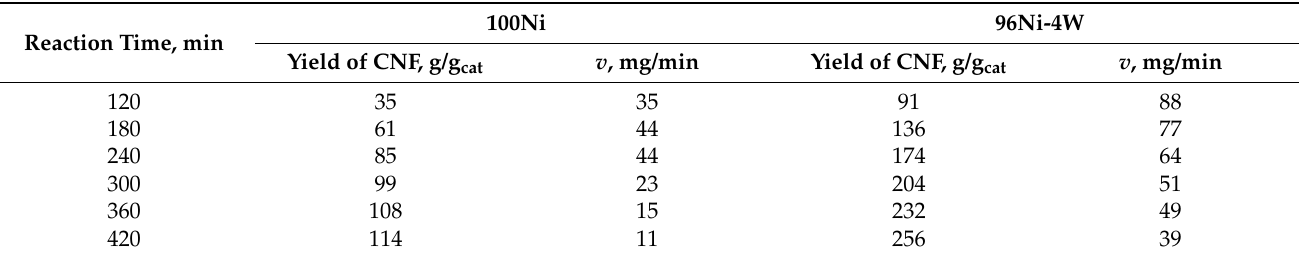
Table 3. Parameters of the TCE decomposition reaction carried out over 100Ni and 96Ni-4W catalysts for 7 h at 600 ◦